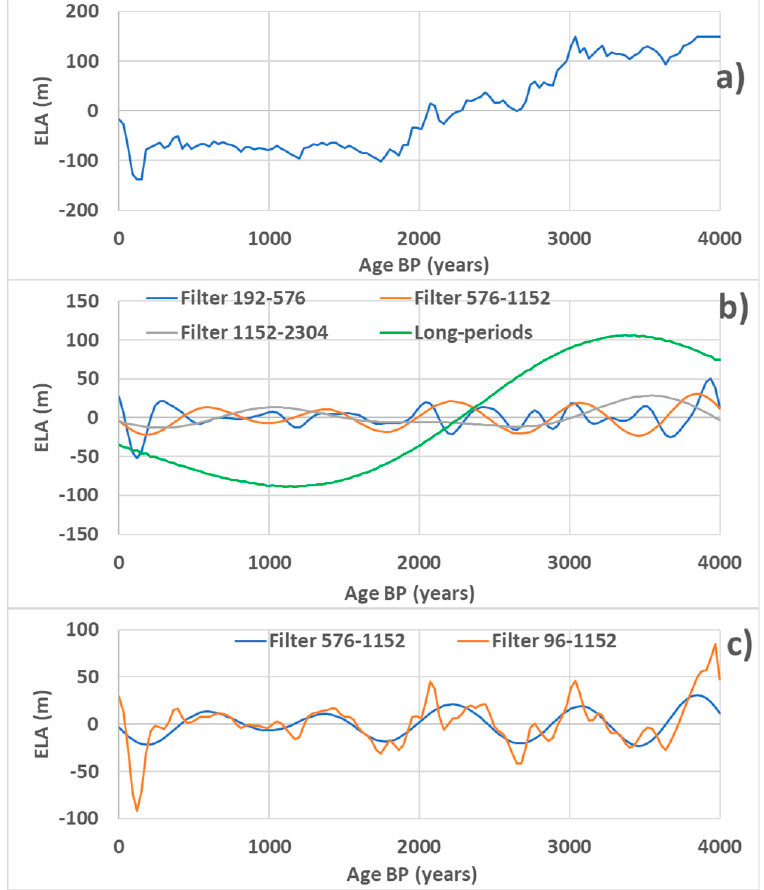
Figure 6. Equilibrium-line altitudes (ELA) of a glacier on the Lyngen Peninsula, northern Norway; ( a ) raw signal; ( b ) signal filtered in the characteristic bands of subharmonic modes n 3 = 2 2 , n 4 = 3 × 2 2 , and n 5 = 3 × 2 3 (mean periods = 256, 768, and 1536 yrs) and the long periods; ( c ) sig- nal filtered in the band 576–1152 yrs characteristic of the subharmonic mode n 4 = 3 × 2 2 (mean period = 768 yrs), and in the band 96–1152 yrs, which includes the modes n 2 = 2 1 , n 3 = 2 2 , and n 4 = 3 × 2 2 (mean periods = 128, 256, and 768